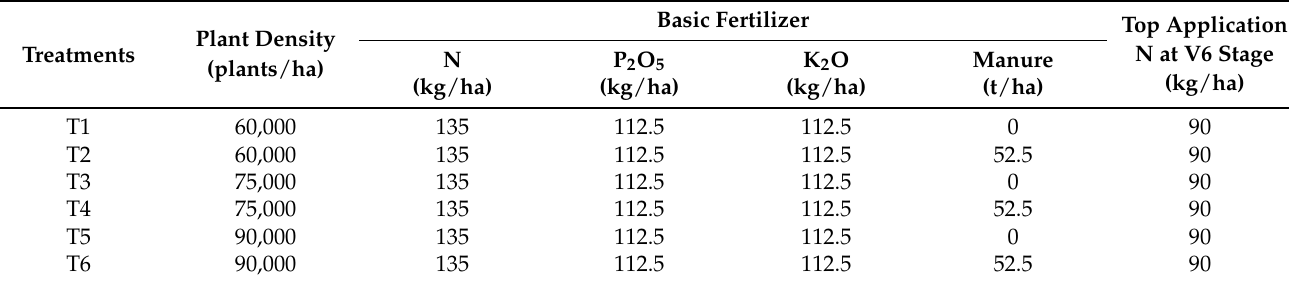
Table 1. The experiments design and fertilizer